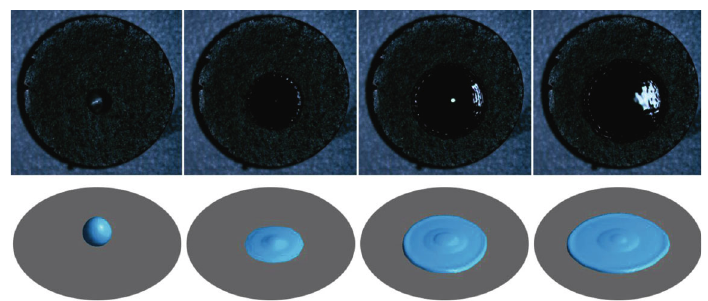
Figure 1: Experimental and simulation results of the droplet impact on coal surface.